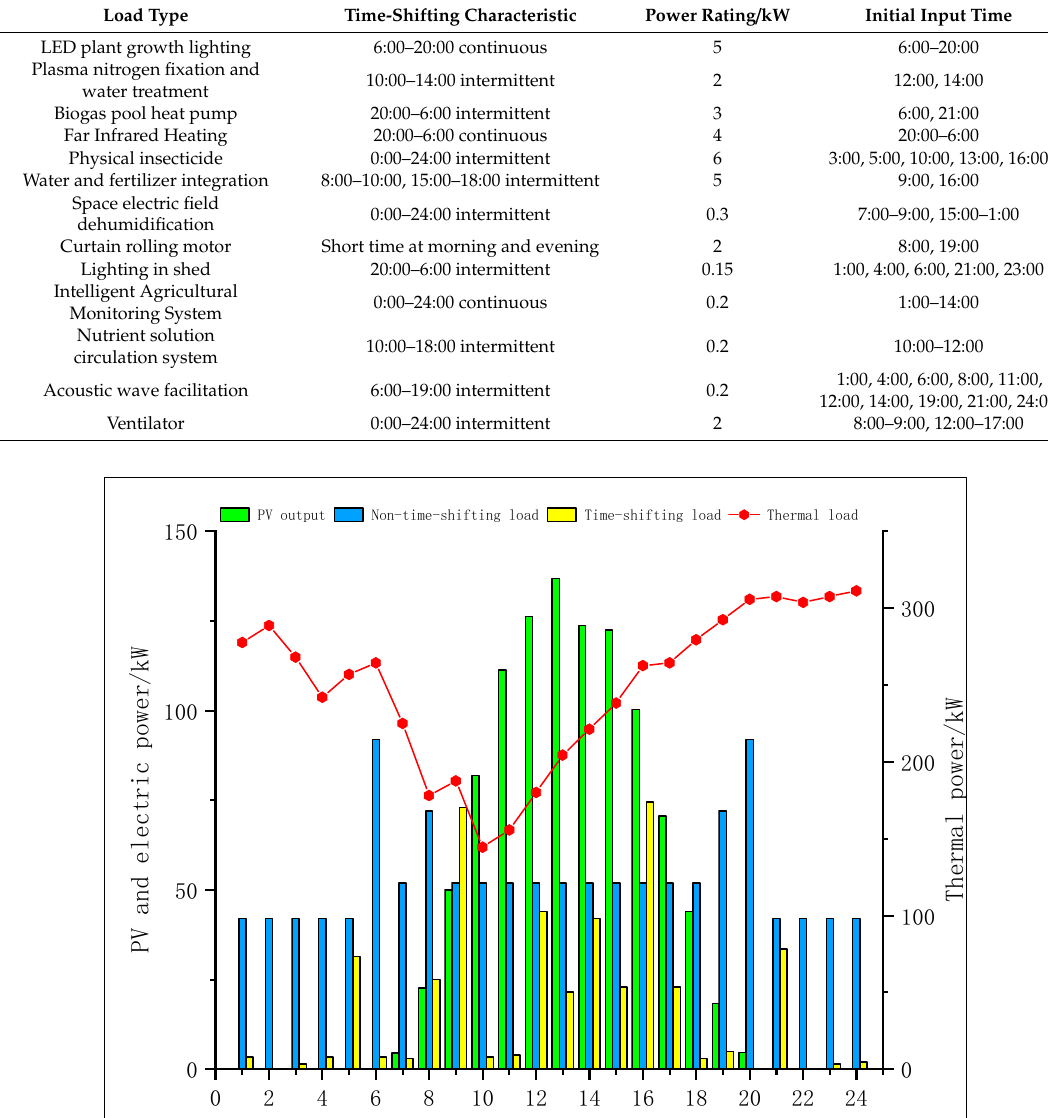
Table 9. Time-shifting characteristics and the input time of non-time-shifting load at initial state for 13 types of electric load.